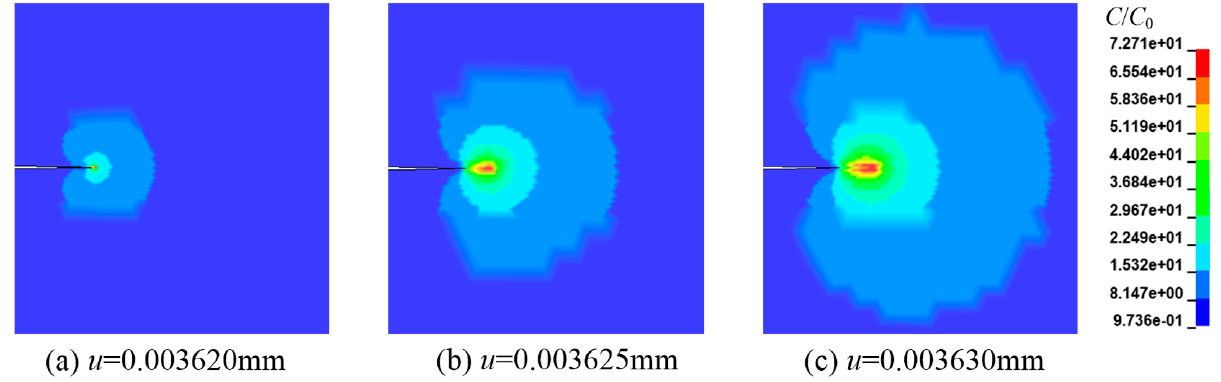
Figure 10. Cloud map of hydrogen concentration during crack growth (C 0 = 0.5 wt ppm) .